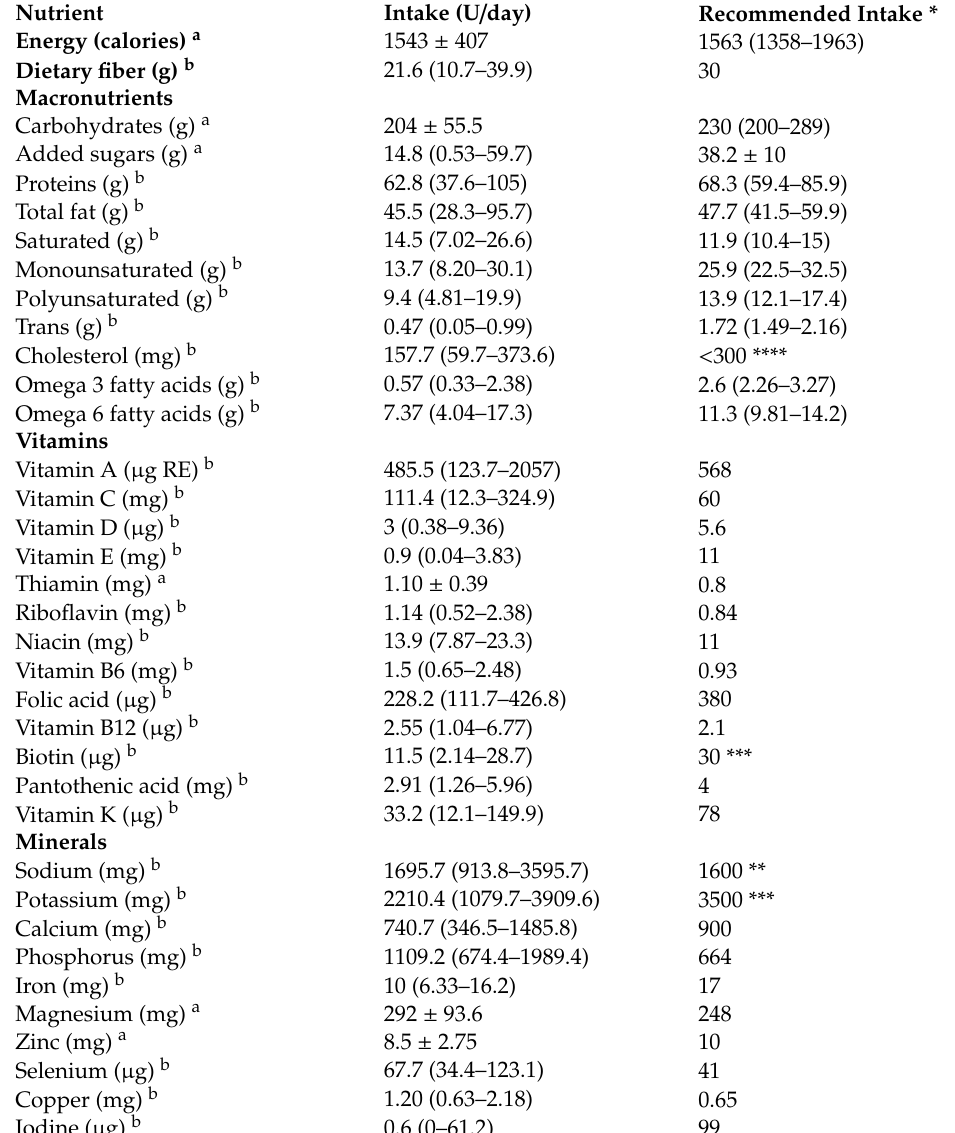
Table 3. Intake of energy and nutrients in all systemic lupus erythematosus (SLE) patients and recommended